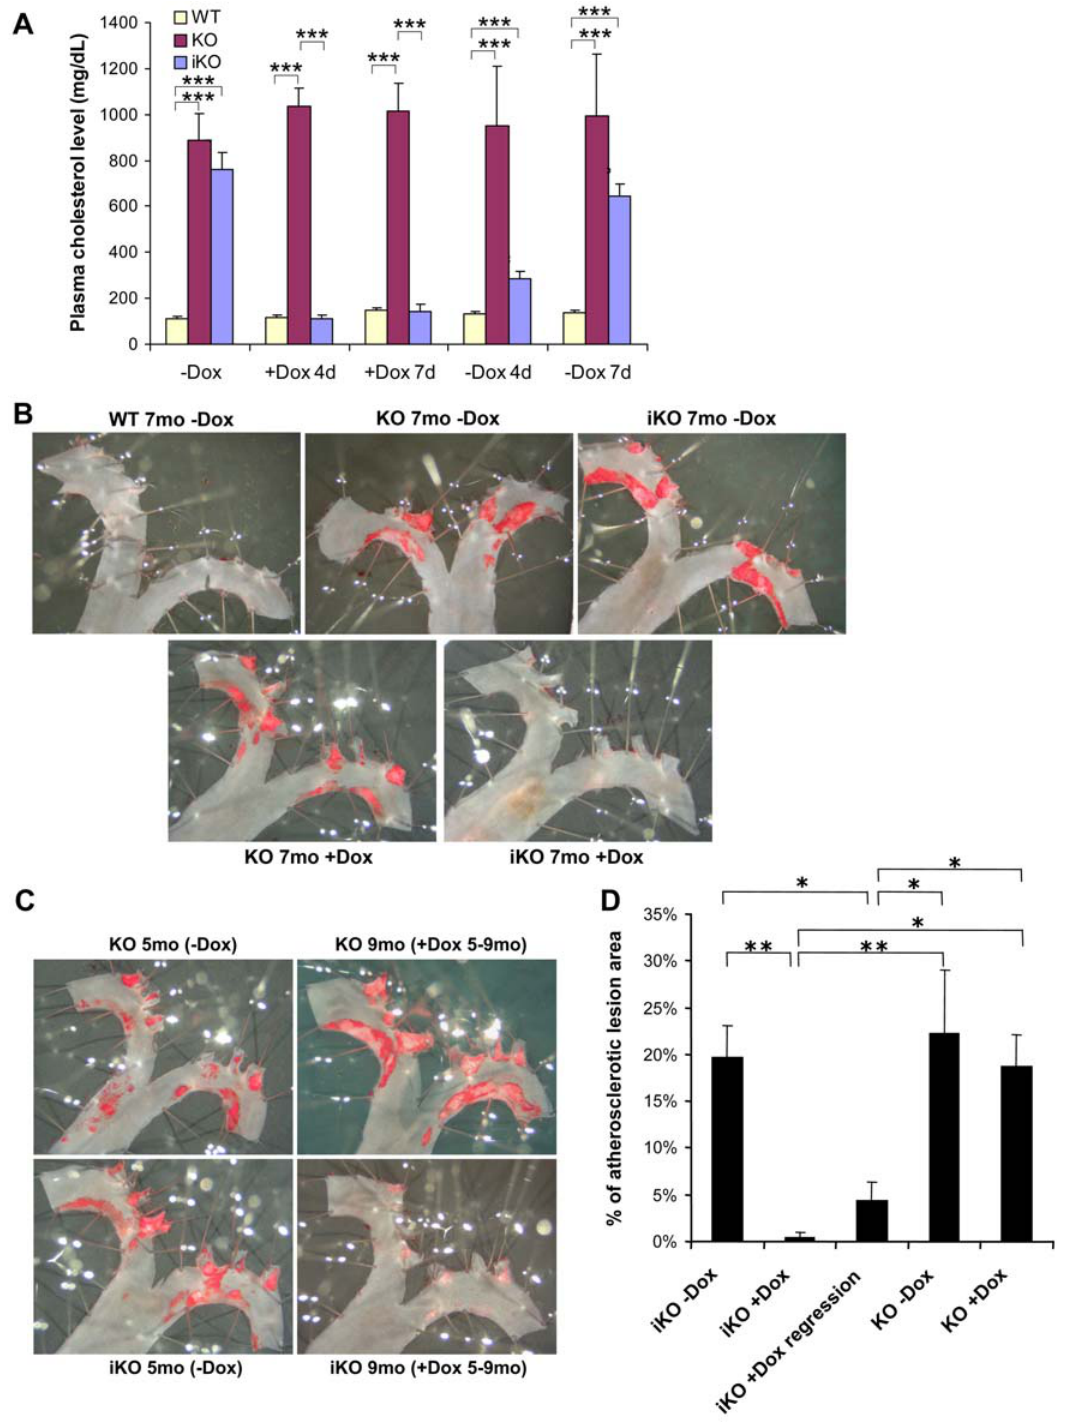
Figure 7. Plasma cholesterol levels and atherosclerotic lesion progression/regression regulated by Dox in ApoE iKO mice. (A) Plasma cholesterol levels in the ApoE iKO, KO and WT group mice in the absence and presence of Dox. (Littermate mice of various genotypes other than homozygous KO or iKO, i.e. ApoE + / + , ApoE + / 2 , ApoE + / + ;TRE-ApoE and ApoE + / 2 ;TRE-ApoE, all displayed normal and indistinguishable blood cholesterol levels, and never developed lesions under any treatment regime used in our study. Consequently they were lumped together as the ‘‘WT group’’.) Plasma cholesterol levels were first measured in mice fed with normal food without Dox ( 2 Dox) and both ApoE iKO and KO mice showed significantly higher cholesterol levels compared to WT group mice (p=0.35 between iKO and KO, p , 0.0001 between iKO and WT or between KO and WT, Student’s t-test). The mice were then switched to Dox-containing food, and plasma cholesterol levels were measured again 4 days ( + Dox 4d) and 7 days ( + Dox 7d) later. Cholesterol level of ApoE iKO mice dropped to WT levels in less than 4 days while that of ApoE KO remained high (p , 0.0001 between iKO and KO or between KO and WT, p=0.86 between iKO and WT). Sometime later, some Dox-treated mice were switched back to normal food, and plasma cholesterol levels were measured again 4 days ( 2 Dox 4d) and 7 days ( 2 Dox 7d) after Dox withdrawal. Cholesterol level of ApoE iKO mice significantly elevated by day 4 (p , 0.001 between iKO and WT, p , 0.01 between iKO and KO) and approached pre-Dox treatment level by day 7